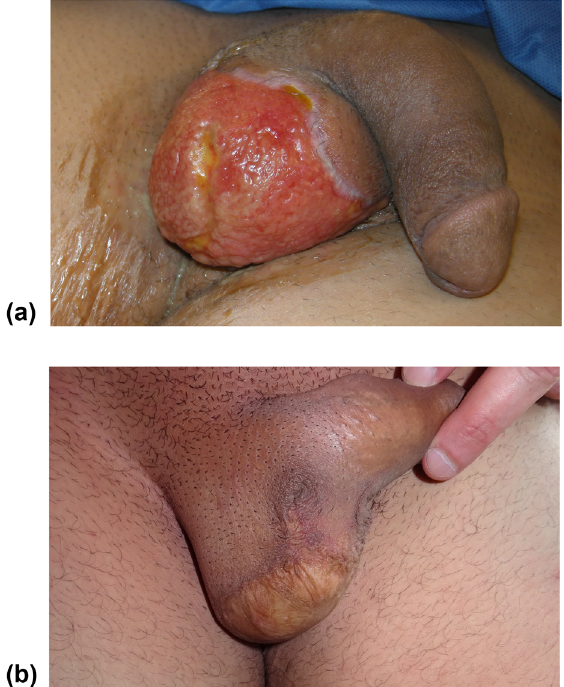
Figure 4: ( a ) Loss of substance of 2/3 of the skin of the scrotum in a 35 - year - old patient with gangrene, evolved from an abscess of the gluteal region. ( b ) Reconstruction of the scrotum with the residual skin of the right scrotum and a sliding fl ap from the inner face of the contralateral thigh based on the perforating vessels of the ingu - inal fold.